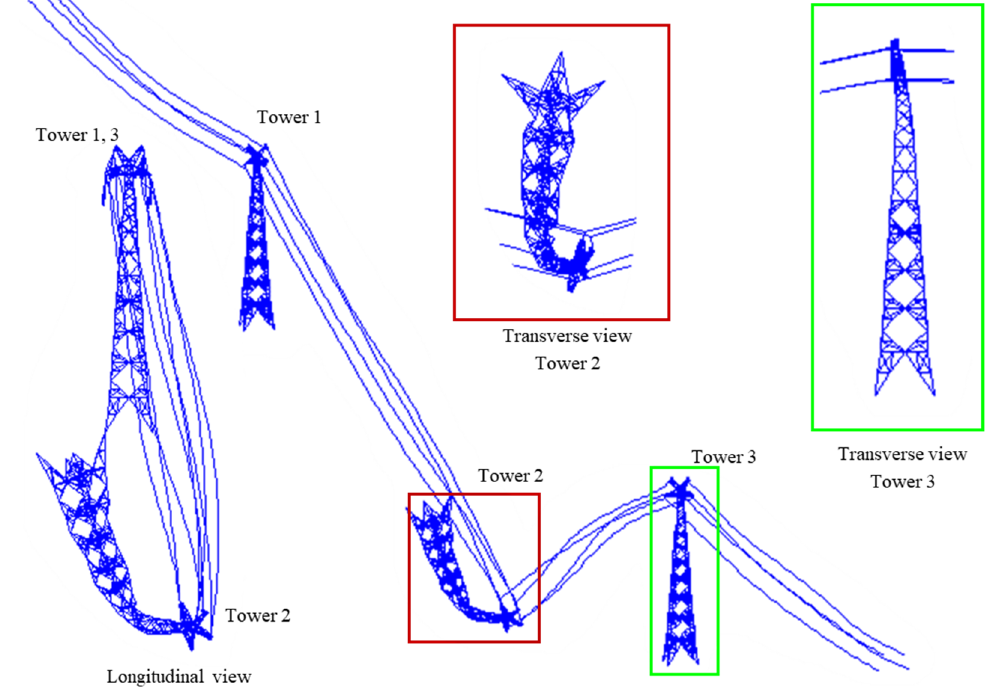
Figure 18. Behavior of the transmission tower-line structure at t = 13.8 s under Case 2.